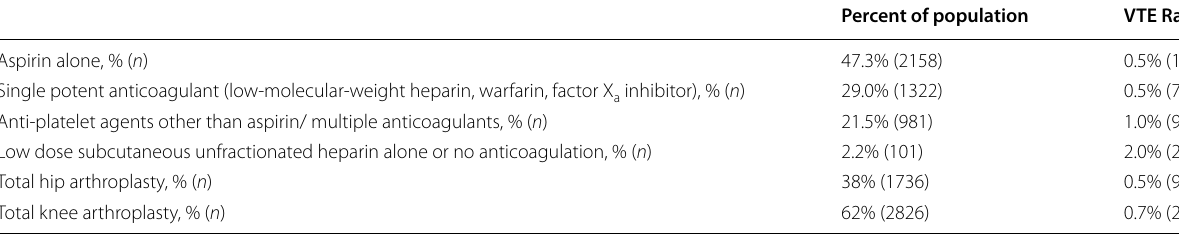
Percent of population VTE Rate